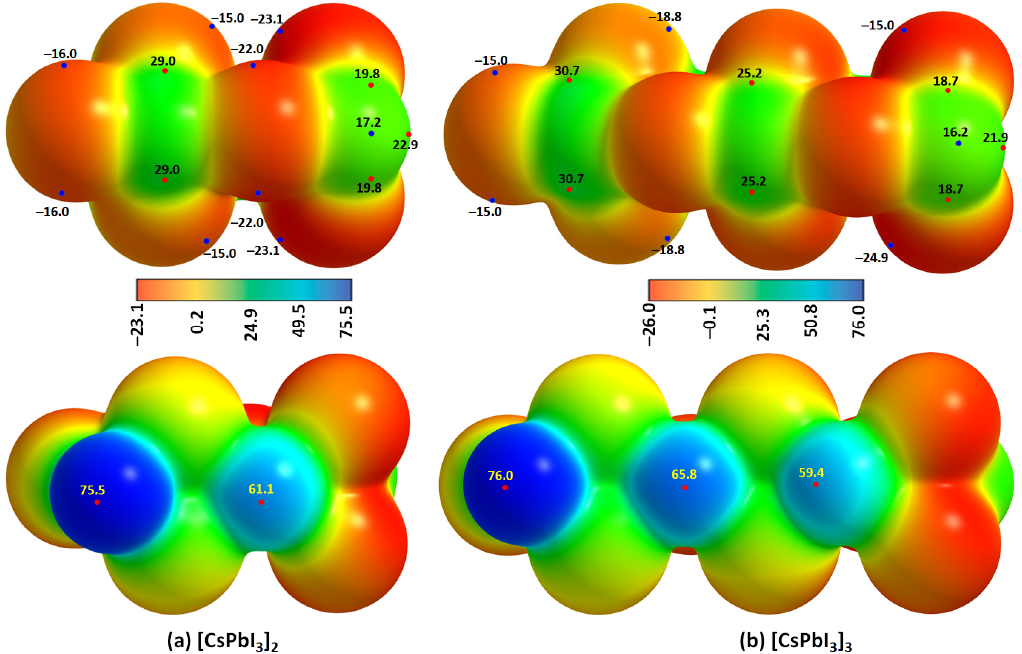
Figure 15. The [ ω B97Xd/def2-TXVPPD] computed potential on the electrostatic surface of the ( a ) tronic density envelopes. The top and bottom panels represent that Pb and Cs sites of each Cs•PbI 3 ion-pair in the dimer/trimer are facing the viewer, respectively. Selected local most maxima and minima of potential ( V S,max and V S,min ) represented by tiny circles in red and blue, respectively, are depicted. Values are given in kcal mol − 1 . are depicted. Values are given in kcal mol − 1